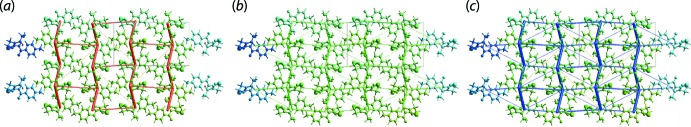
The energy framework diagrams for (I) showing (a) E
electrostatic (red cylinders), (b) E
dispersion (green cylinders) and (c) E
total (blue cylinders), viewed along the a axis. The frameworks were adjusted to the same scale factor of 50 with a cut-off value of 2.39 kcal mol−1 within 2 × 2 × 2 unit cells. The corresponding cylinder radii are proportional to the relative magnitude of the energies.